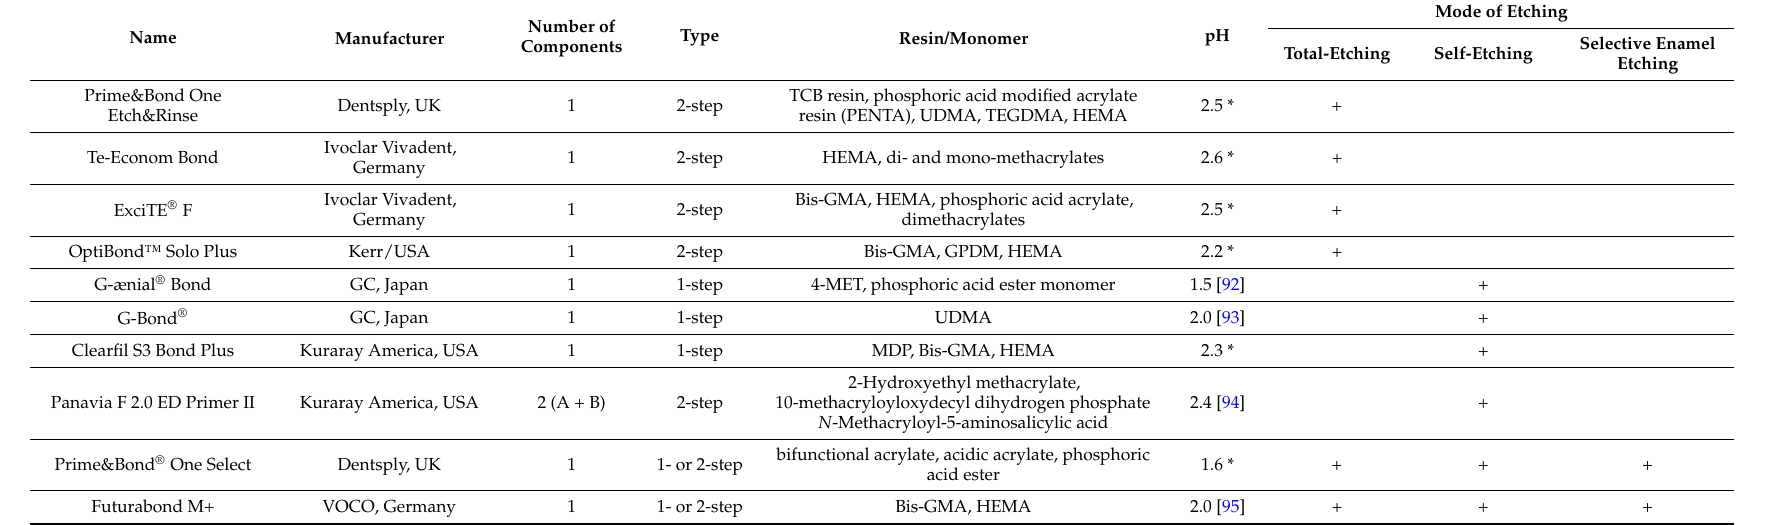
Table 3. Commercial bonding systems used in the